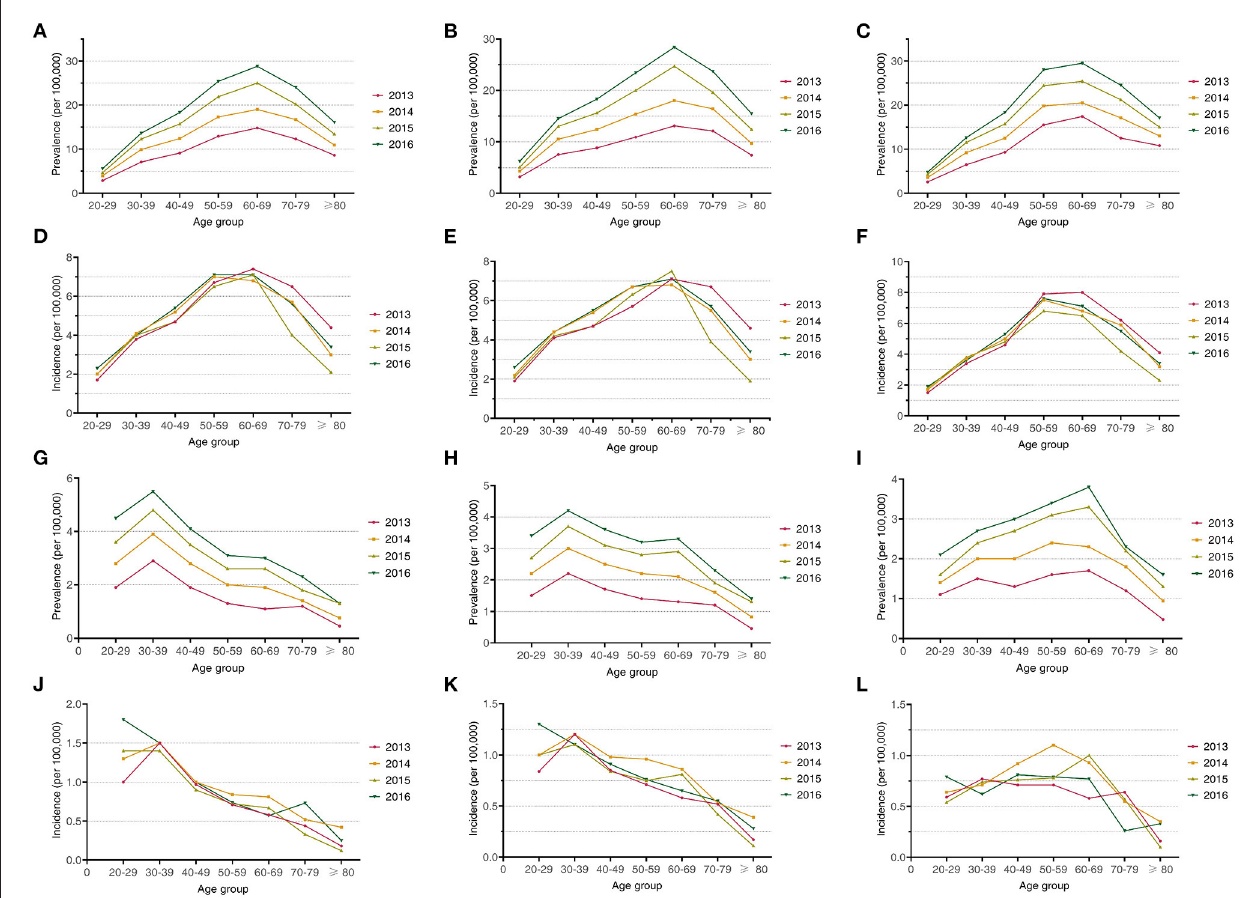
FIGURE 1 | (A) The prevalence of UC patients from different age groups; (B) the prevalence of male UC patients from different age groups; (C) the prevalence of female UC patients from different age groups; (D) the incidence of UC patients from different age groups; (E) the incidence of male UC patients from different age groups; (F) the incidence of female UC patients from different age groups; (G) the prevalence of CD patients from different age groups; (H) the prevalence of male CD patients from different age groups; (I) the prevalence of female CD patients from different age groups; (J) the incidence of CD patients from different age groups; (K) the incidence of male CD patients from different age groups; and (L) the incidence of female CD patients from different age